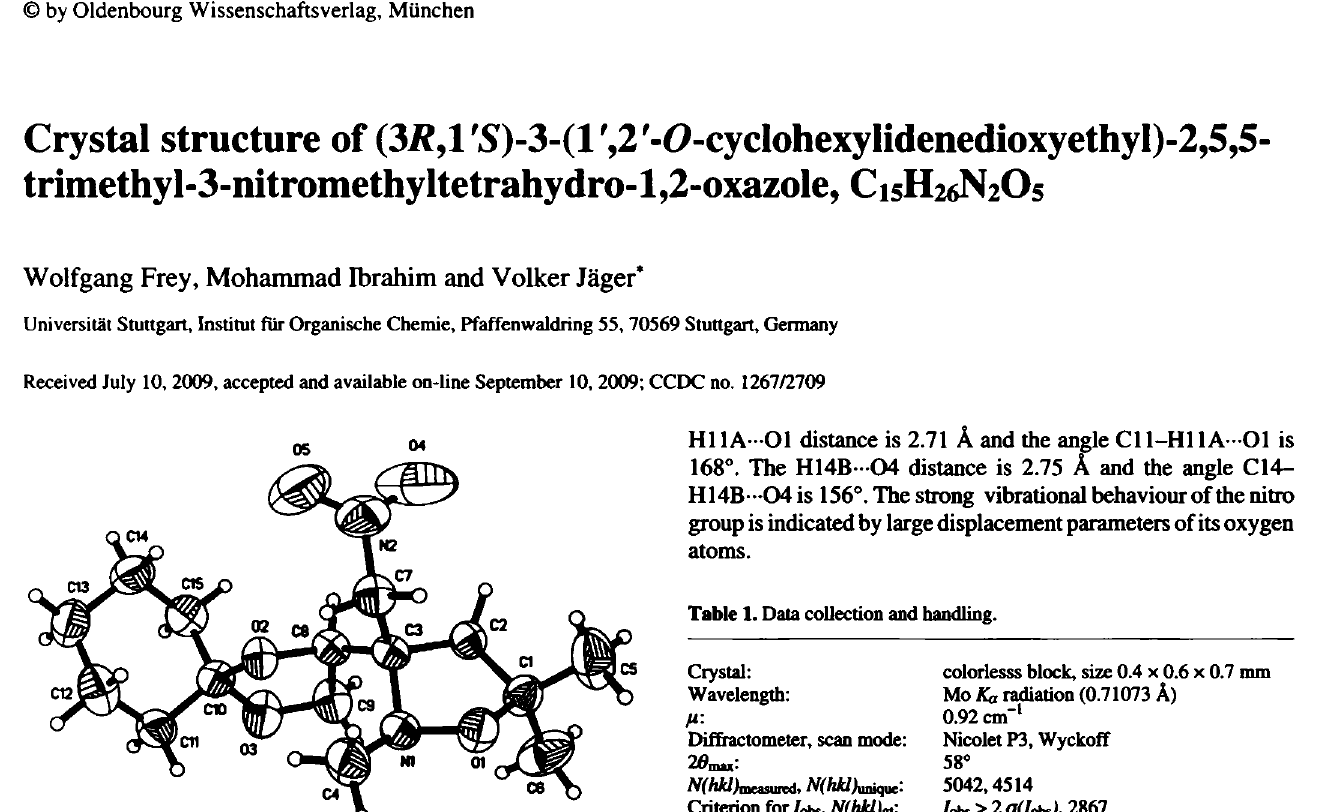
Table 2. Atomic coordinates and displacement parameters (in Â 2